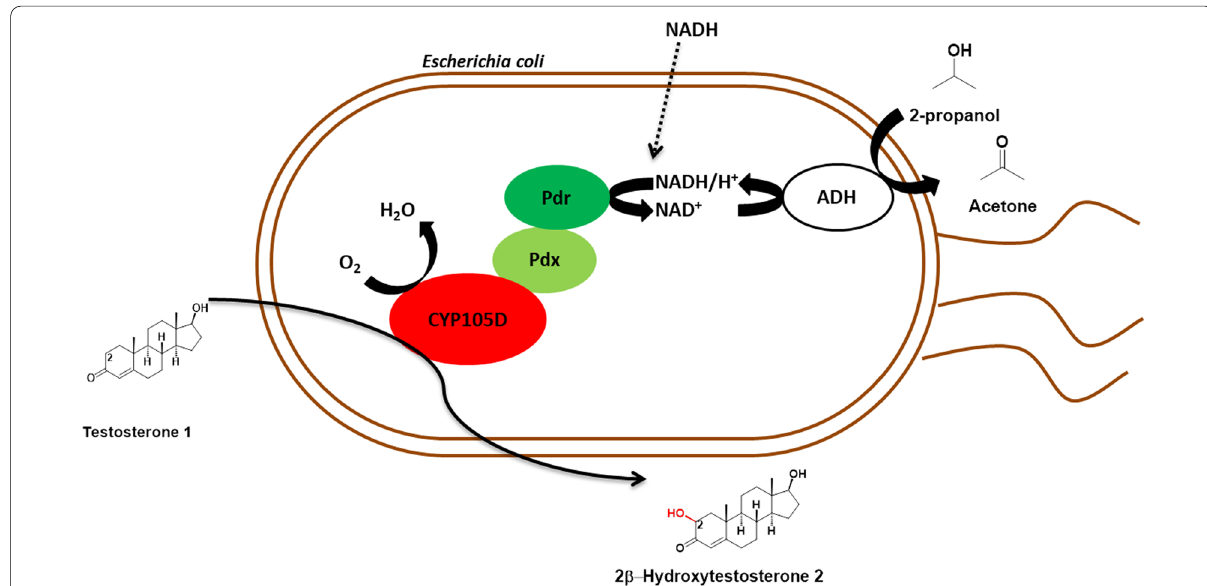
Fig. 1 Schematic overview of the whole-cell biocatalyst expressing CYP105D from S. platensis for the oxidation of testosterone 1 . Putidaredoxin reductase (Pdr) and putidaredoxin (Pdx) from P. putida are used as redox partners for CYP105D. Alcohol dehydrogenase (ADH) from R. erythropolis was implemented for cofactor regeneration using propan-2-ol as sacrificial substrate and solvent for testosterone